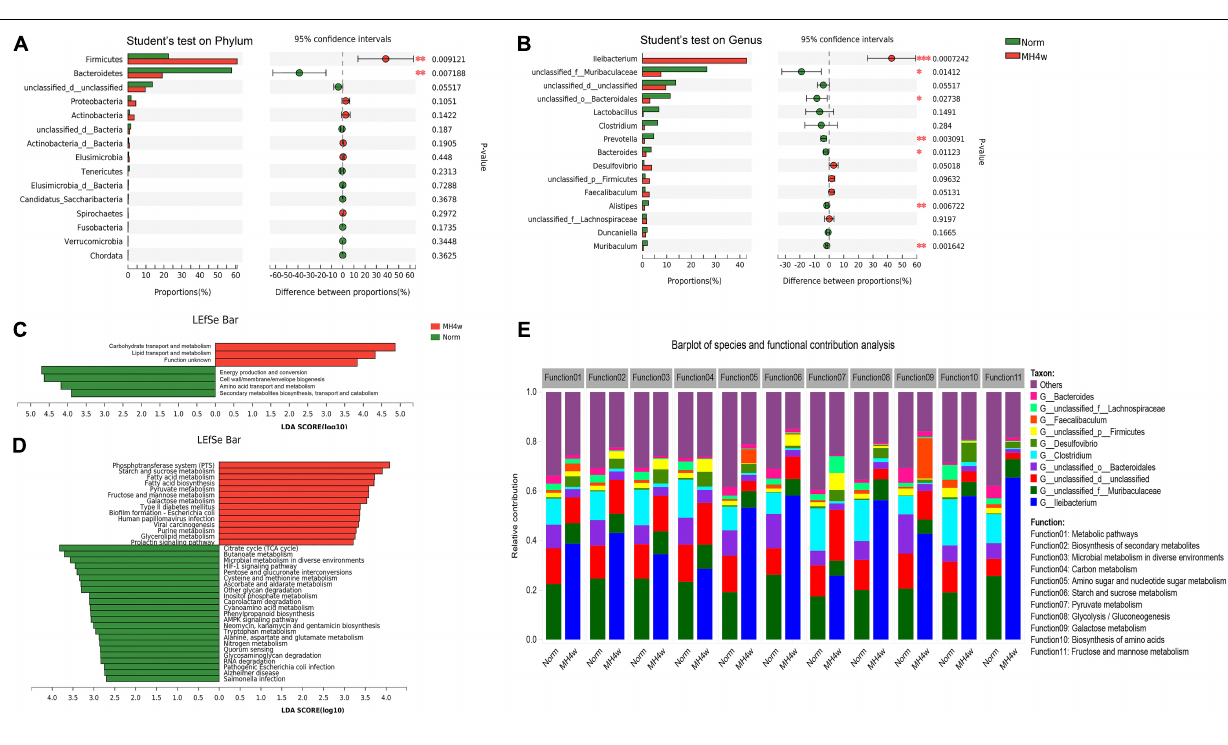
Frontiers in Cardiovascular Medicine |